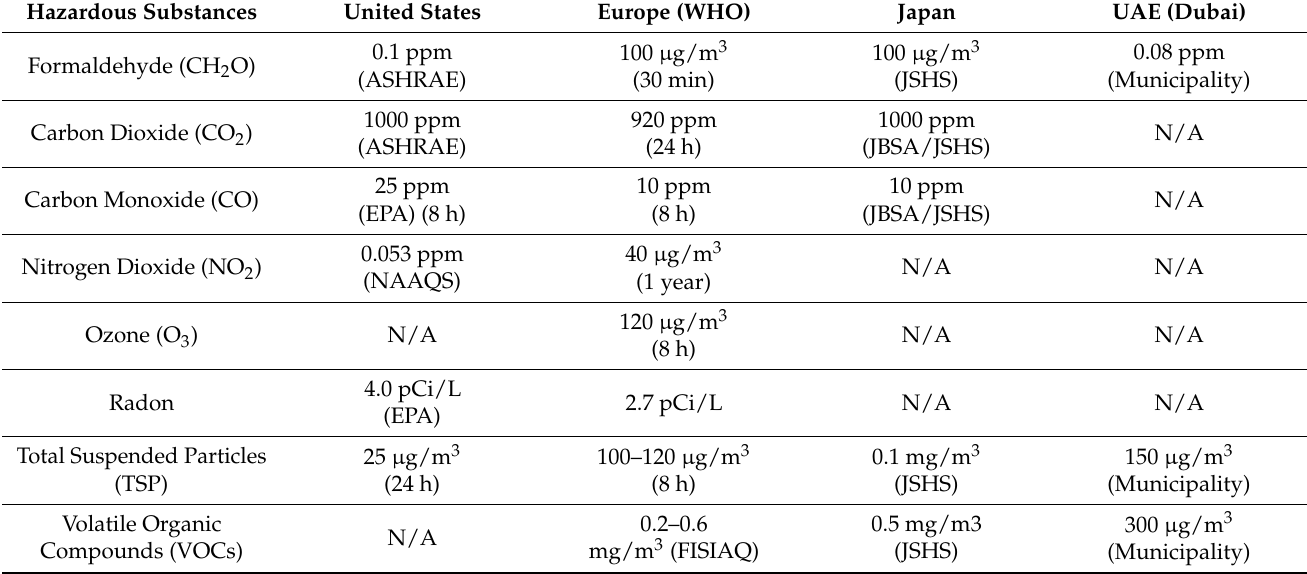
Table 3. Global standards for indoor air